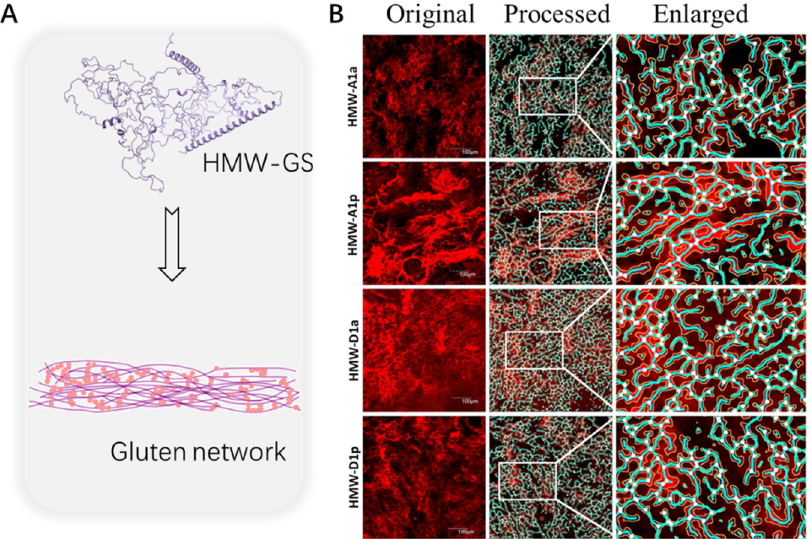
Figure 3. Role of HMW-GS in the gluten network ( A ) and confocal laser scanning microscopy of gluten samples of four wheat lines ( B ). Adapted with permission from Ref. [22]. 2018, Elsevier.